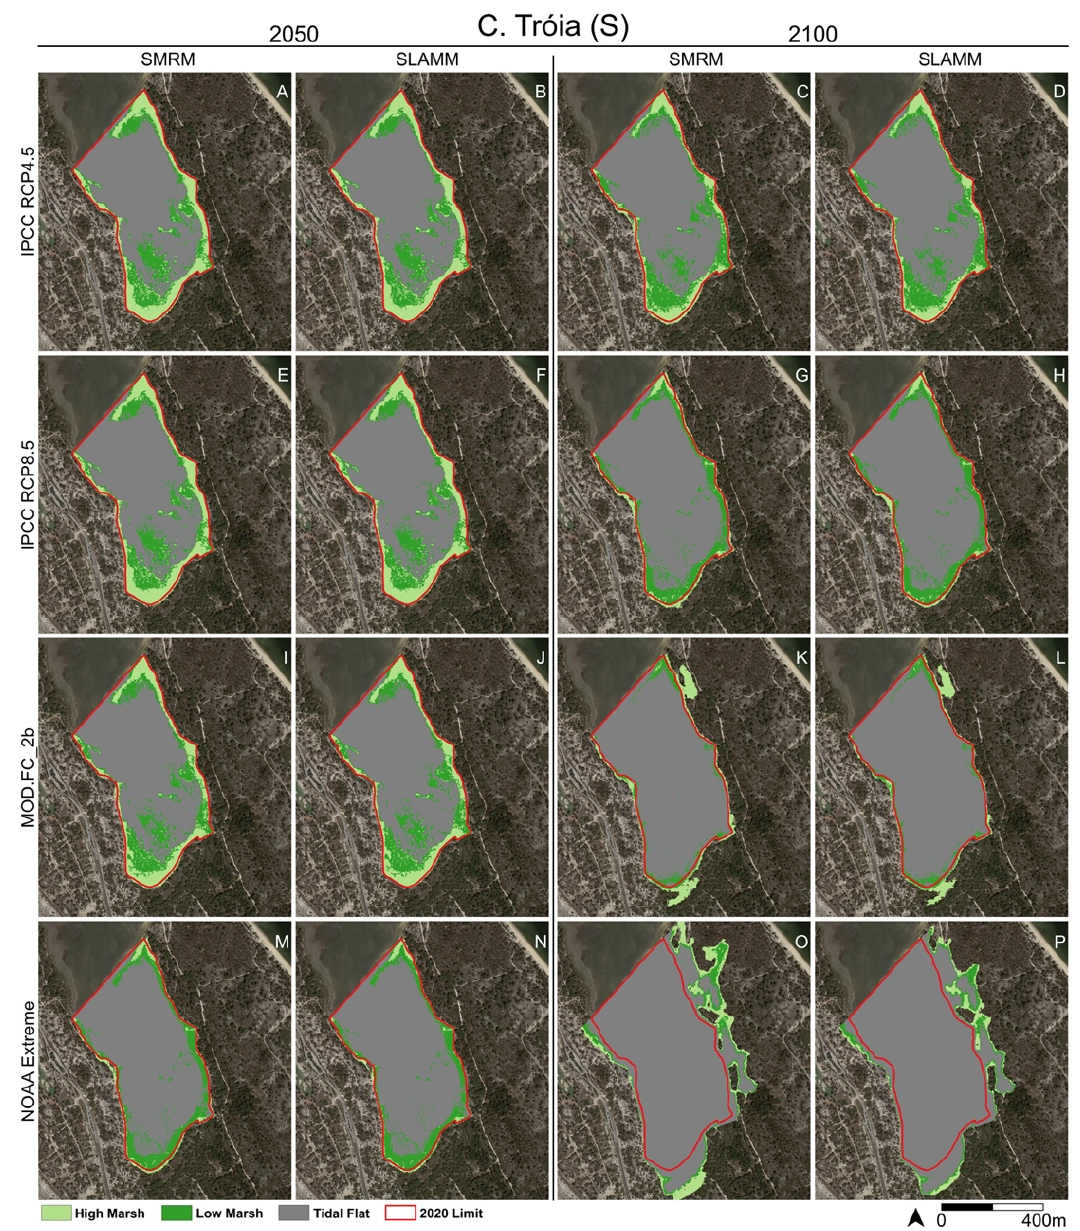
Figure 9. C. Tróia (S) salt marsh morphological maps for 2050 and 2100, using SMRM and SLAMM. Results are presented for the considered SLR scenarios: IPCC RCP4.5 ( A – D ), IPCC RCP8.5 ( E – H ), MOD.FC_2b ( I – L ), and NOAA Extreme ( M – P ).